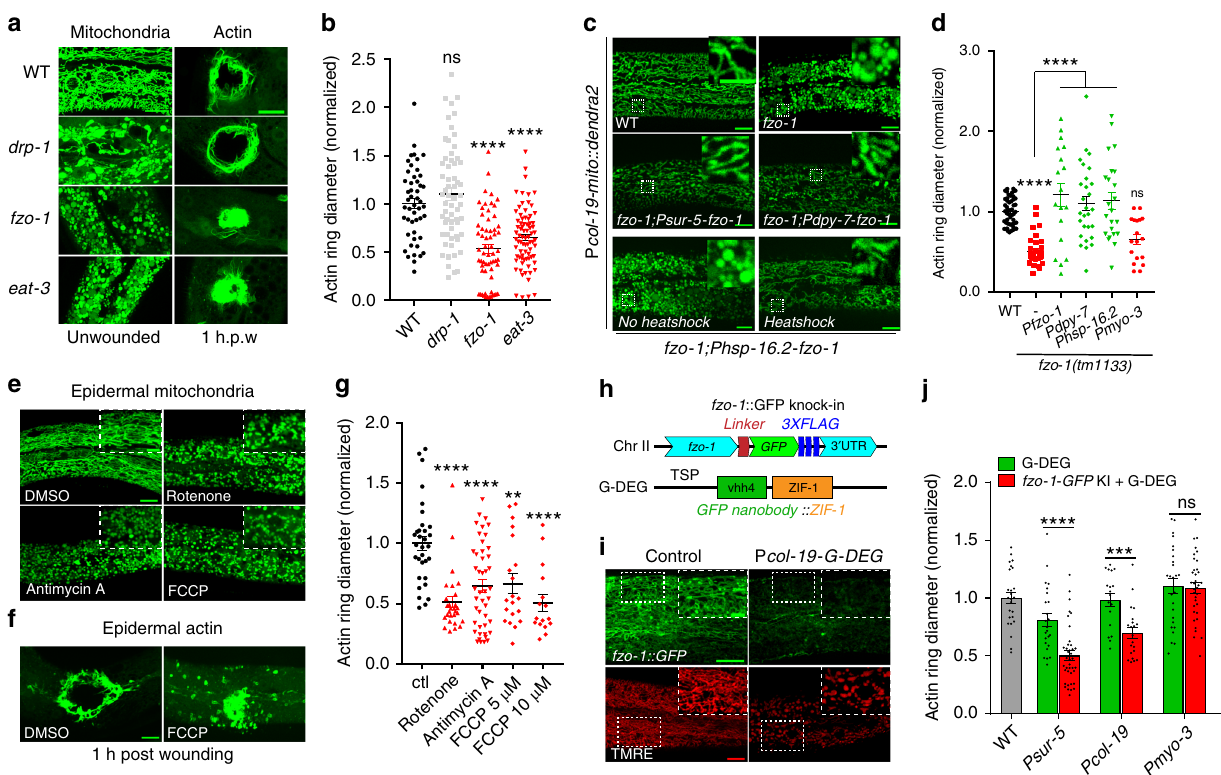
Fig. 2 Enhanced mitochondrial fragmentation accelerates wound closure. a Left, representative confocal images of mitochondria in WT and mutants; right, representative images of F-actin ring assembly (P col-19-GFP::moesin(juIs352) ) at 1 h.p.w. (hour post-wounding). N = 4 independent experiments. b Quantitation of actin ring diameter in wounded animals (WT, n = 49; drp-1 , n = 61; fzo-1 , n = 62; eat-3 , n = 79 animals). Bars indicate mean ± SEM, normalized to WT. **** P < 0.0001 (versus WT), One-way ANOVA, Dunnett ’ s post test. c Representative images of mitochondria in fzo-1(tm1133) or tissue- speci fi c rescued strains. d Quantitation of actin ring diameter (WT, n = 51; fzo-1 , n = 35; fzo-1;Pfzo-1-fzo-1 , n = 18; fzo-1;Pdpy-7-fzo-1 , n = 28; fzo-1;Phsp-16.2- fzo-1 , n = 23; fzo-1;Pmyo-3-fzo-1 , n = 23 animals) at 1 h.p.w. Bars indicate mean ± SEM. **** P < 0.0001 (versus fzo-1 ), One-way ANOVA Dunnett ’ s test. Two- tailed unpaired t -test for fzo-1 and WT animals. e Left top, representative images of mitochondria morphology. Rotenone (100 μ M), antimycin A (100 μ M). and FCCP (10 μ M). f Actin ring formation after wounding. N = 3 independent experiments ( e , f ). g Quantitation of actin ring diameter in WT and drug treated animals (Ctl, n = 31; Rotenone, n = 28; antimycin A, n = 33; FCCP 5 μ M, n = 20; FCCP 10 μ M, n = 16 animals) at 1 h.p.w. Bars indicate mean ± SEM. ** P = 0.016, **** P < 0.0001 (versus ctl ), One-way ANOVA Dunnett ’ s test. h A scheme of fzo-1::GFP(zju136) and GFP nanobody mediated degradation system (G-DEG). i Representative images of fzo-1::GFP expression in animals with or without G-DEG. N = 3 independent experiments. j Quantitation of actin ring diameter after tissue-speci fi c knockdown of fzo-1 (WT, n = 25; Psur-5;G-DEG , n = 39; Psur-5;G-DEG;fzo-1 , n = 24; Pcol-19;G-DEG , n = 21; Pcol-19; G-DEG;fzo-1 , n = 18; Pmyo-3;G-DEG , n = 26; Pmyo-3;G-DEG;fzo-1 , n = 35 animals). Bars indicate mean ± SEM. ns, P = 0.8508, *** P = 0.0004, **** P <